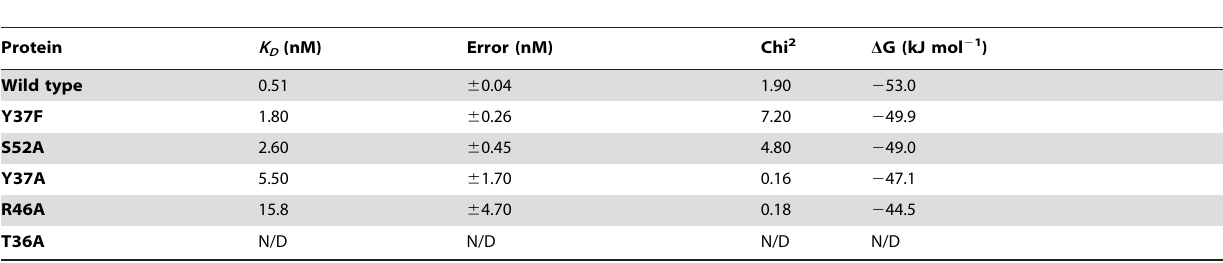
Table 1. Equilibrium SPR analysis of the C.Esp1396I mutant proteins binding to the O M operator.